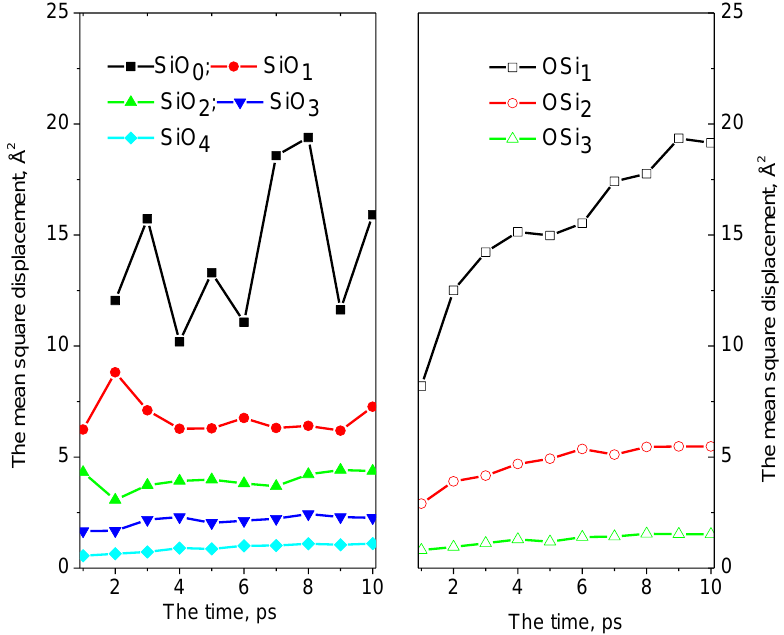
Figure 3. The MSD of SiO x and OSi y units in SiO 2 liquid